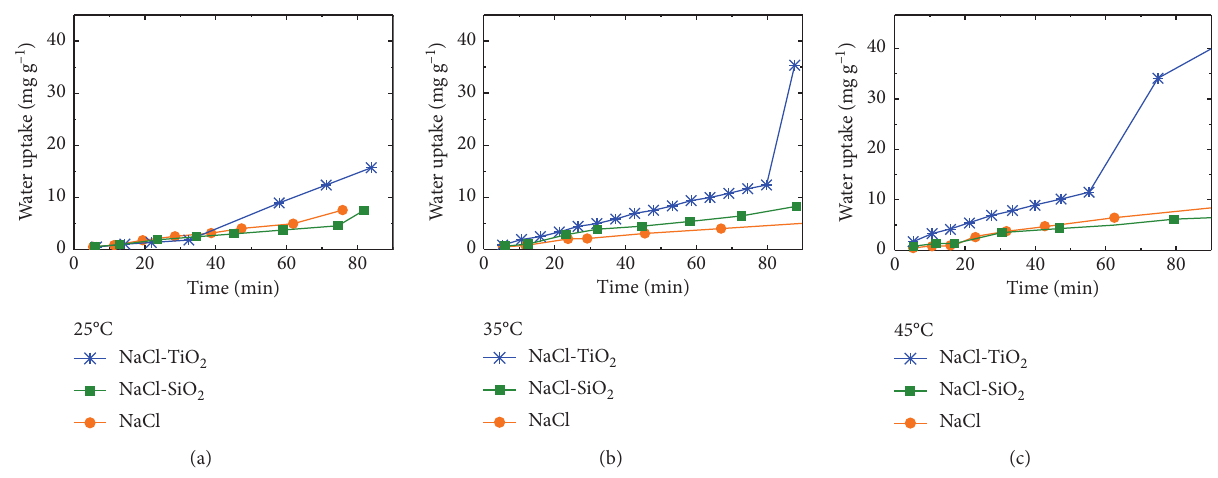
Figure 12: Kinetics of adsorption for NaCl, NaCl-TiO